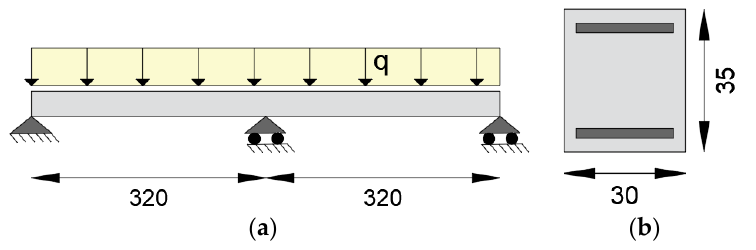
Figure 16. ( a ) Static scheme of the continuous beam; ( b ) cross-section geometry (dimensions in cm).